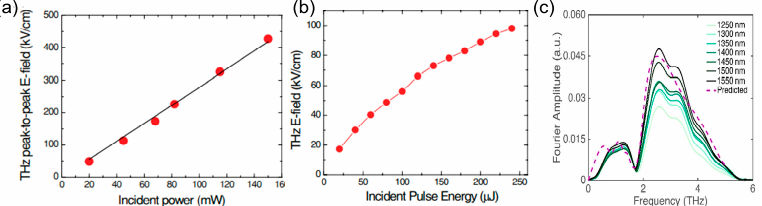
Figure 23. Peak THz E-field generated as a function of incident pulse energy by ( a ) 0.33 mm thick PMB-T [46], ( b ) 0.26 mm thick HMB-TMS [47], and ( c ) THz generation spectrum of P-BI [54].